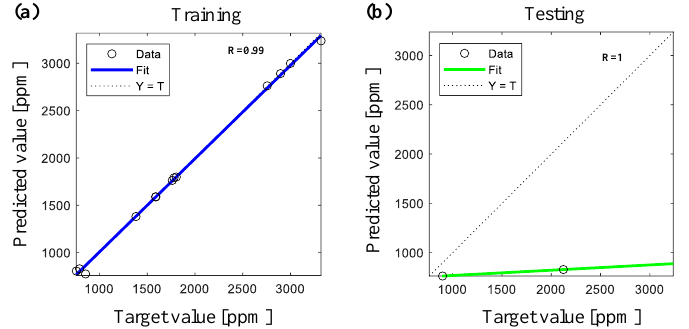
Figure 7. Correlation coefficient between actual and predicted values of nano TiO 2 coated amount after UV treatment using ANN during ( a ) training and ( b ) testing